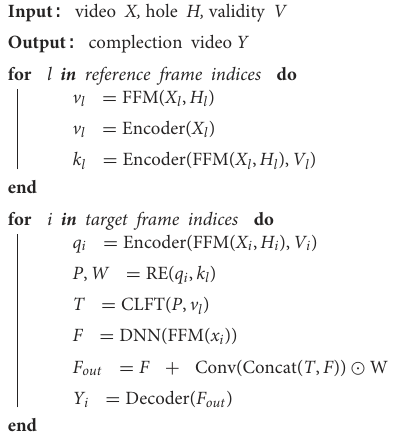
Algorithm 1. Spatial-temporal texture transformer network for video